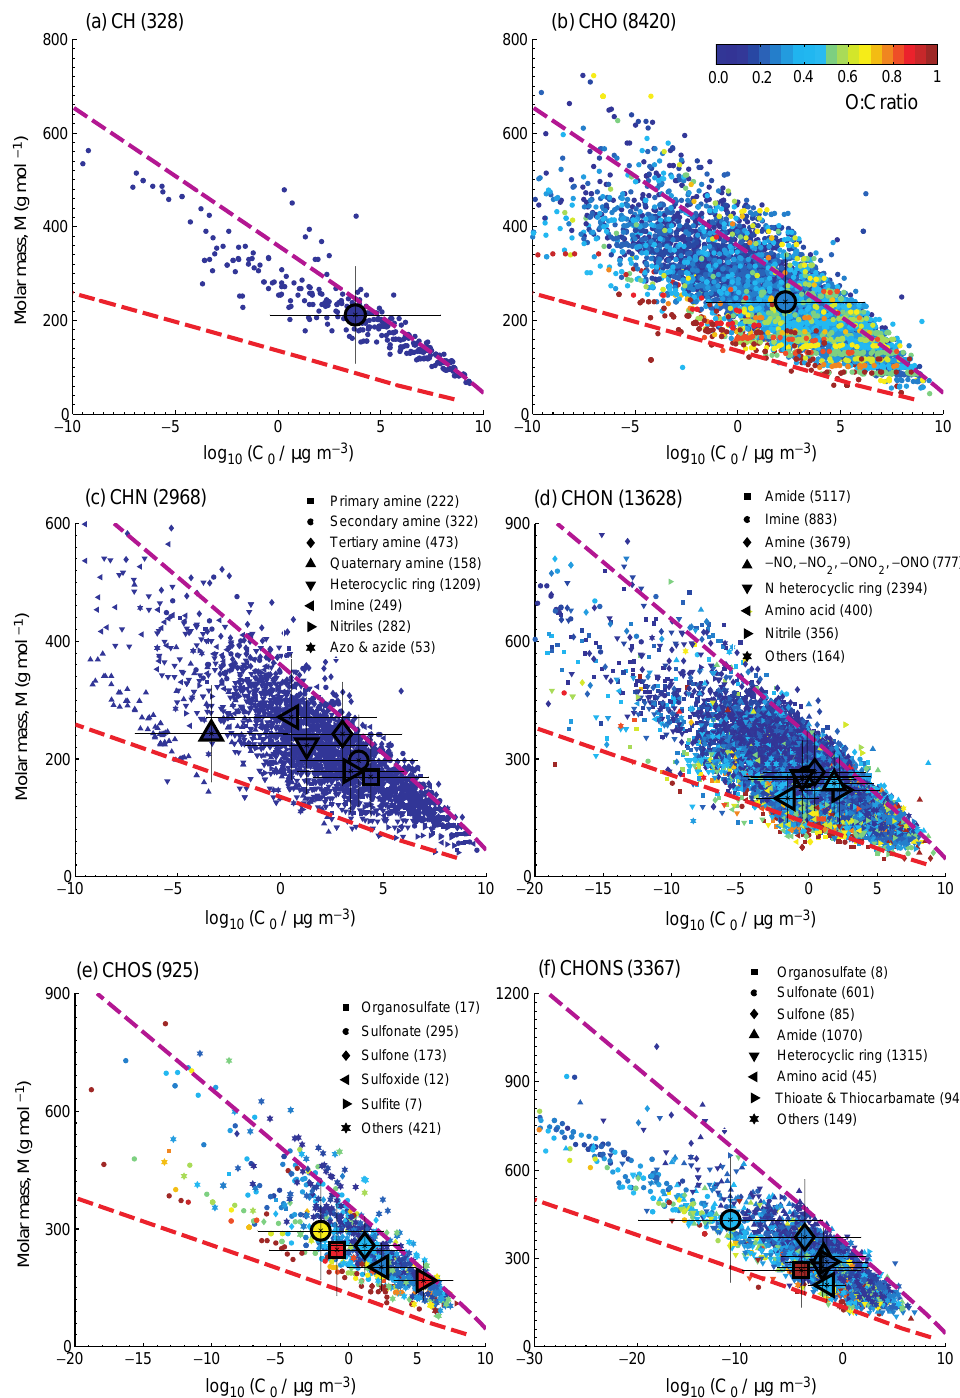
Figure 1. Molecular corridors of molar mass ( M) vs. saturation mass concentration ( C 0 ) for organic compounds in elemental composition classes of (a) CH, (b) CHO, (c) CHN, (d) CHON, (e) CHOS, and (f) CHONS. The data comprise 31066 compounds from the NCI open database. The dotted lines represent linear alkanes C n H 2 n + 2 (purple with O : C = 0) and sugar alcohols C n H 2 n + 2 O n (red with O : C = 1). The small markers correspond to individual compounds identified in each structural sub-class (see Sect. 2), color-coded by atomic O : C ratio. The larger symbols indicate the surrogate compounds with the mean values of M , C 0 , and O : C ratio computed for each of the structural sub-classes with error bars indicating standard deviations. Note that the data points above the linear alkane line in (b) represent molecules with branched